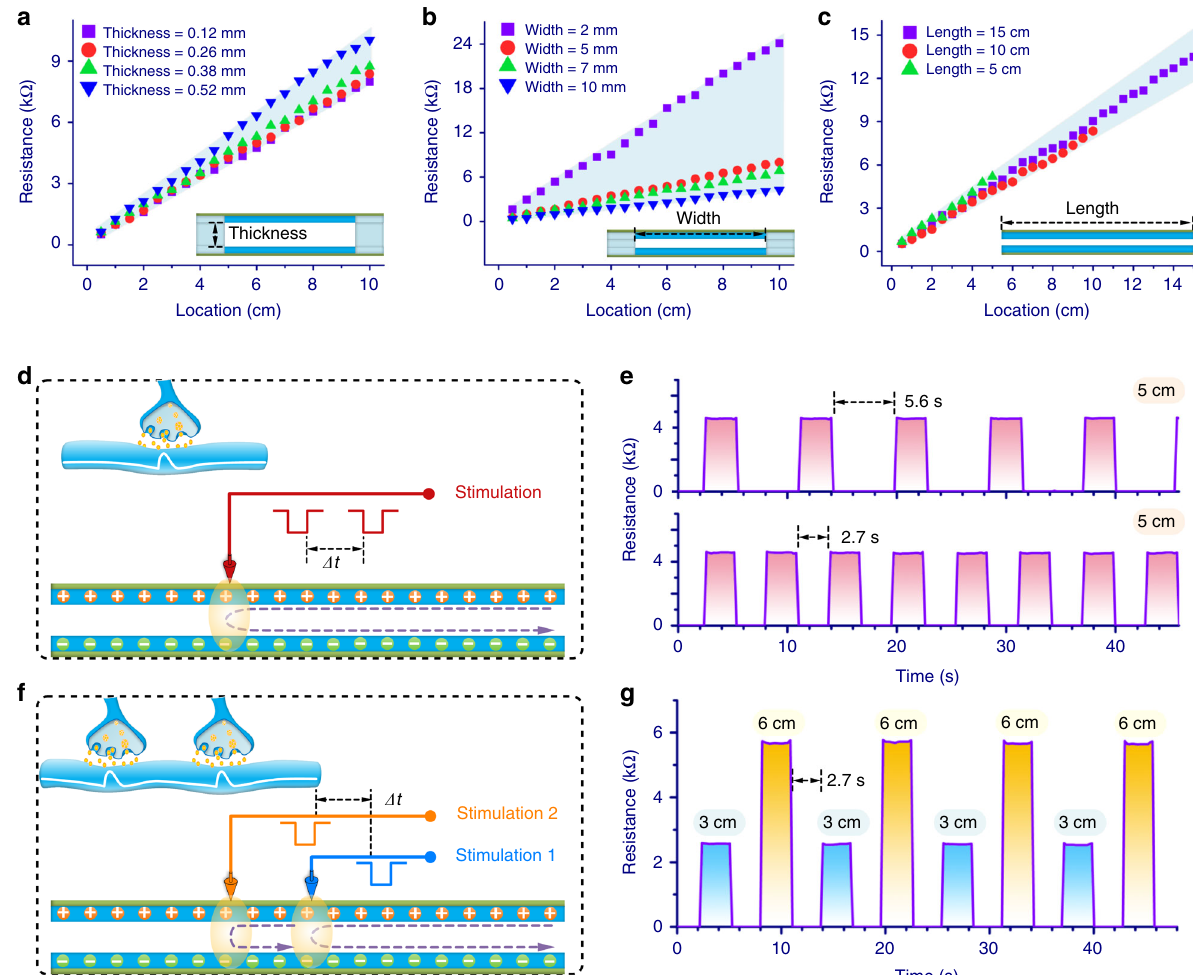
Fig. 2 Performance and characteristic of the APT nerve. a In fl uence of the thickness of spacer on the response resistance of the APT nerve with the active width of 5mm. Relationship between the location of mechanical stimulation and the response resistance of the APT nerve with different active b width and c length when the spacer was 0.12 mm. d Diagram of one type of mechanical stimulation applying on the APT nerve. Top left: Schematic of a single synapse. Δ t is the interval time between adjacent mechanical stimulations. e Change in the response resistance of the APT nerve triggered by the mechanical stimulation at different intervals (5.6 s and 2.7 s). The mechanical stimulation was applied at the location of 5 cm of the APT nerve. f Diagram of mechanical stimulations applying at different locations (3 cm and 6 cm) of the APT nerve. Top left: Schematic of spatiotemporally dynamical stimulations of two synapses. g Spatiotemporally dynamical response of the APT nerve to the mechanical stimulations. The interval was 2.7